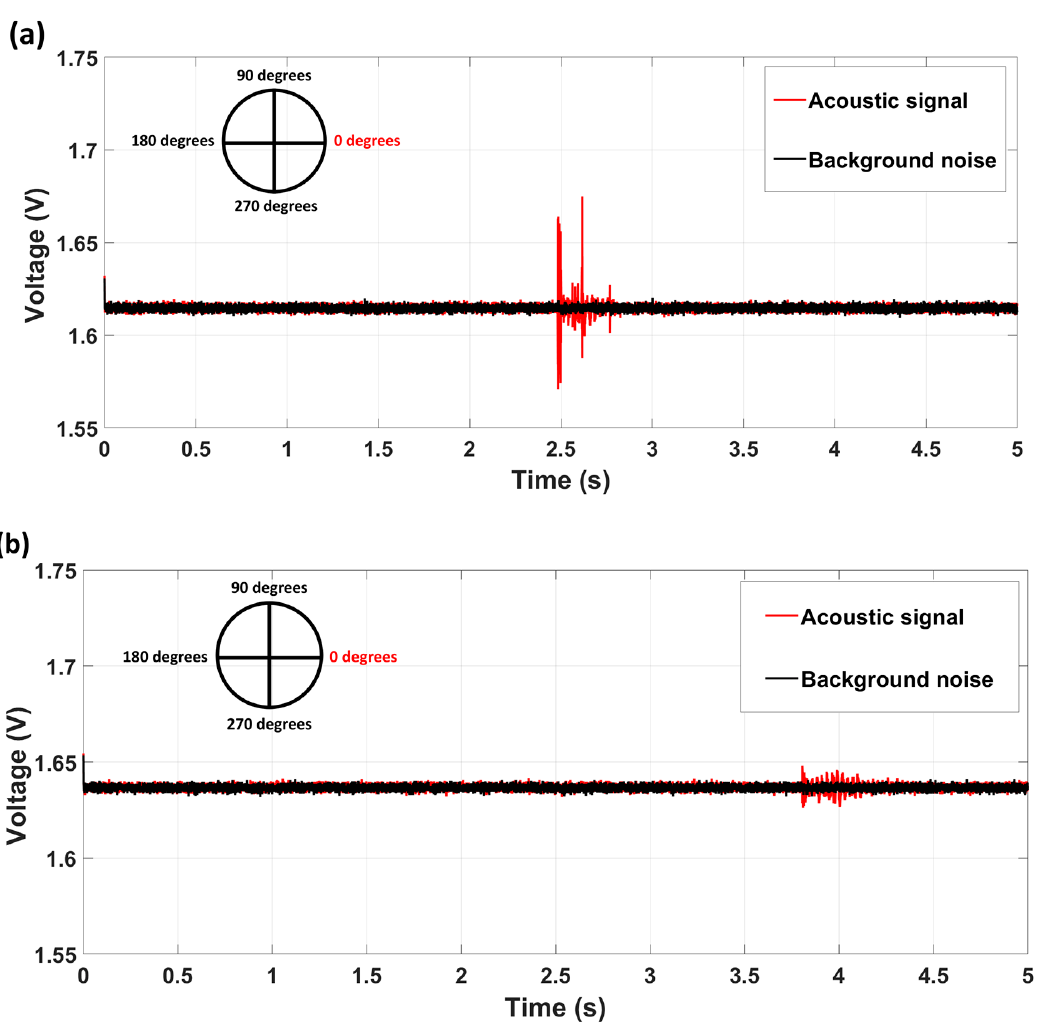
Figure 5. Time domain acoustic signal measured at ( a ) 0 m from the acoustic transmitter and at 0 degrees around the pipe circumference and ( b ) 4 m from the acoustic transmitter and at 0 degrees around the pipe circumference.